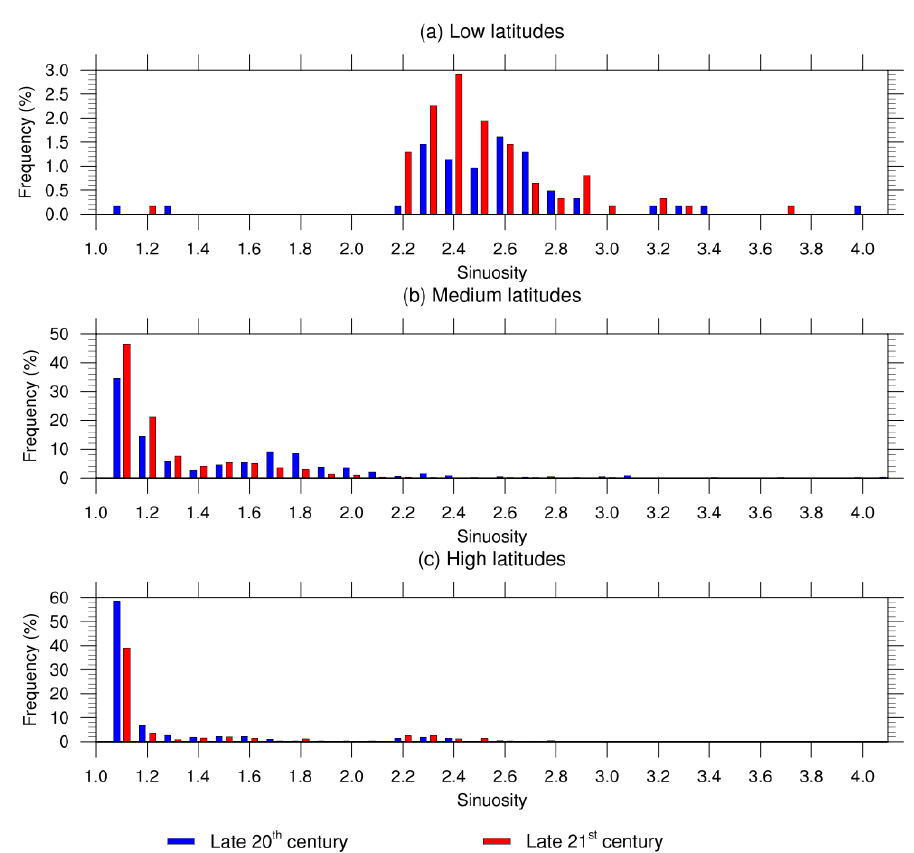
Figure 10. CSIN changes at different latitudes at the late 21st century: ( a ) low latitudes, ( b ) medium latitudes, ( c ) high latitudes.